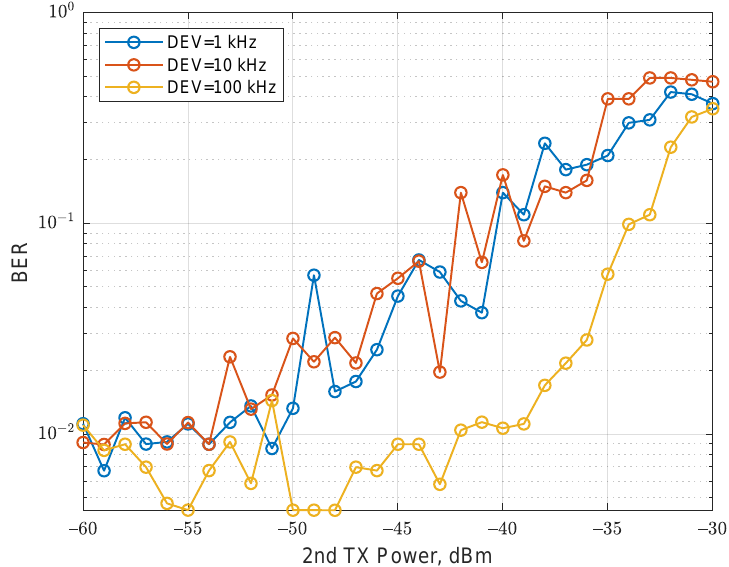
Figure 15. BER versus transmit power of the malicious transmitter. DEV—FM deviation. The receiver gain is 10 dB and the first transmitter power is –36 dBm. The receiver uses a strobe-based